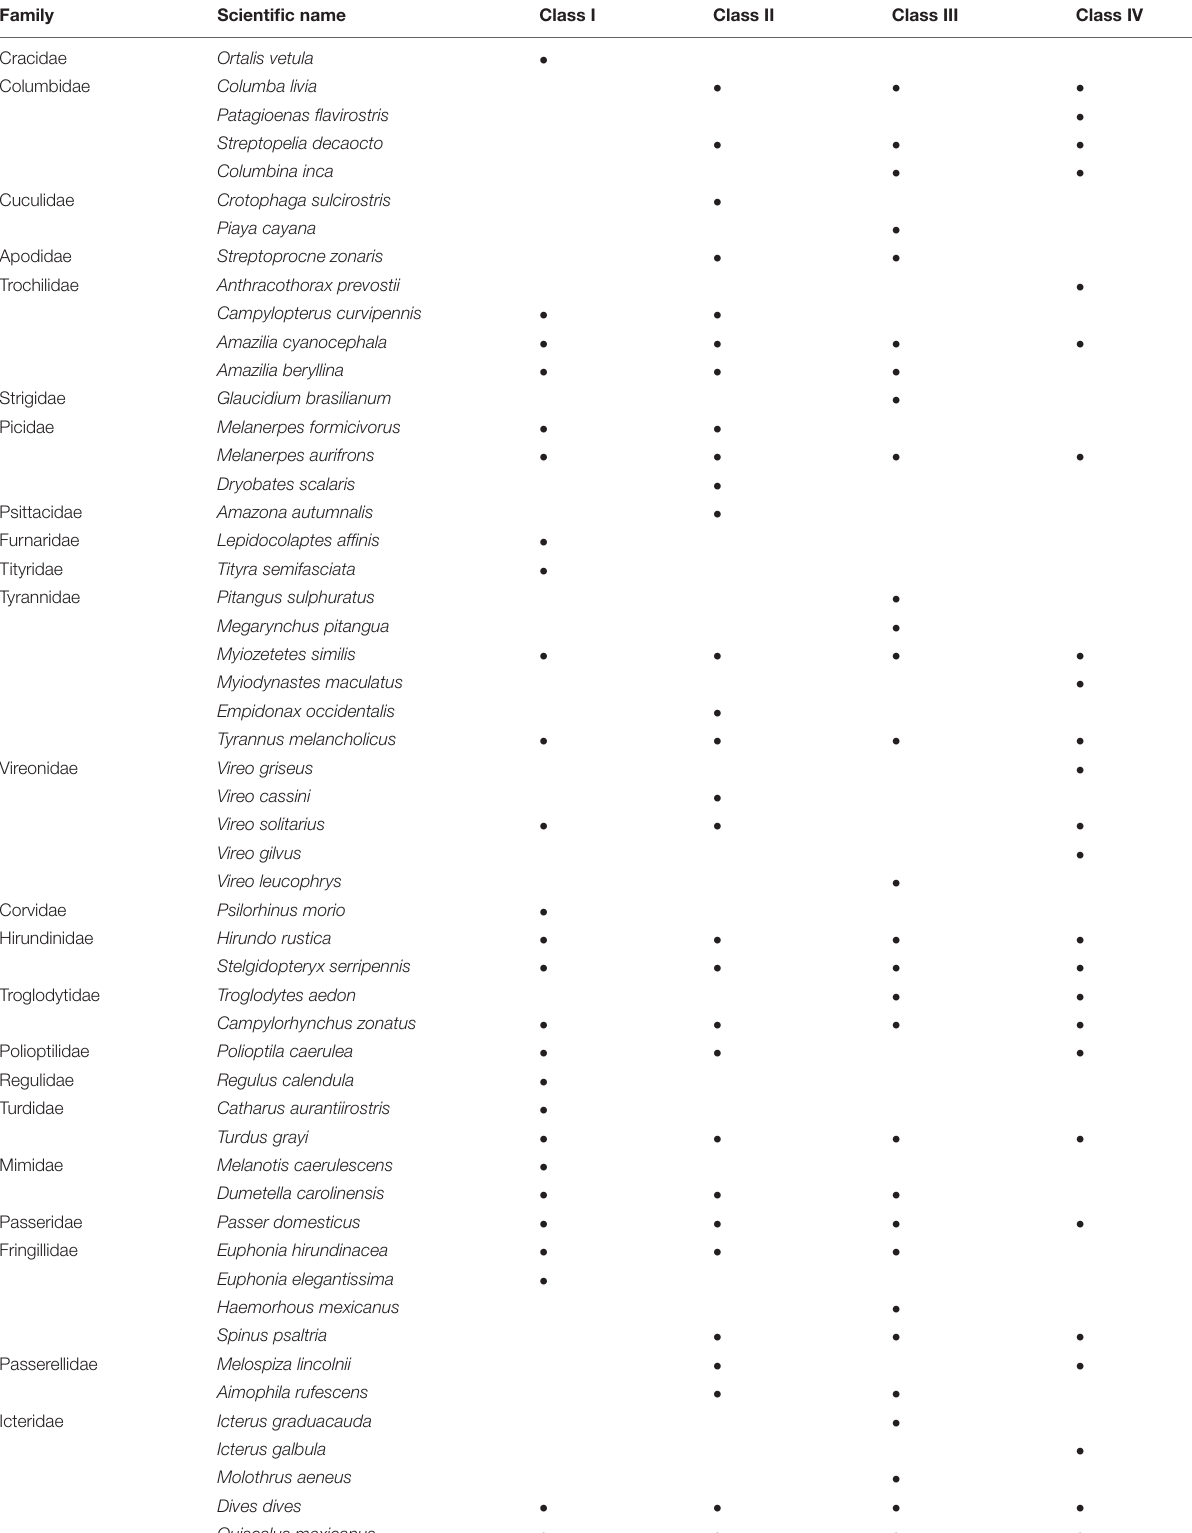
TABLE 1 | List of birds recorded across the city of